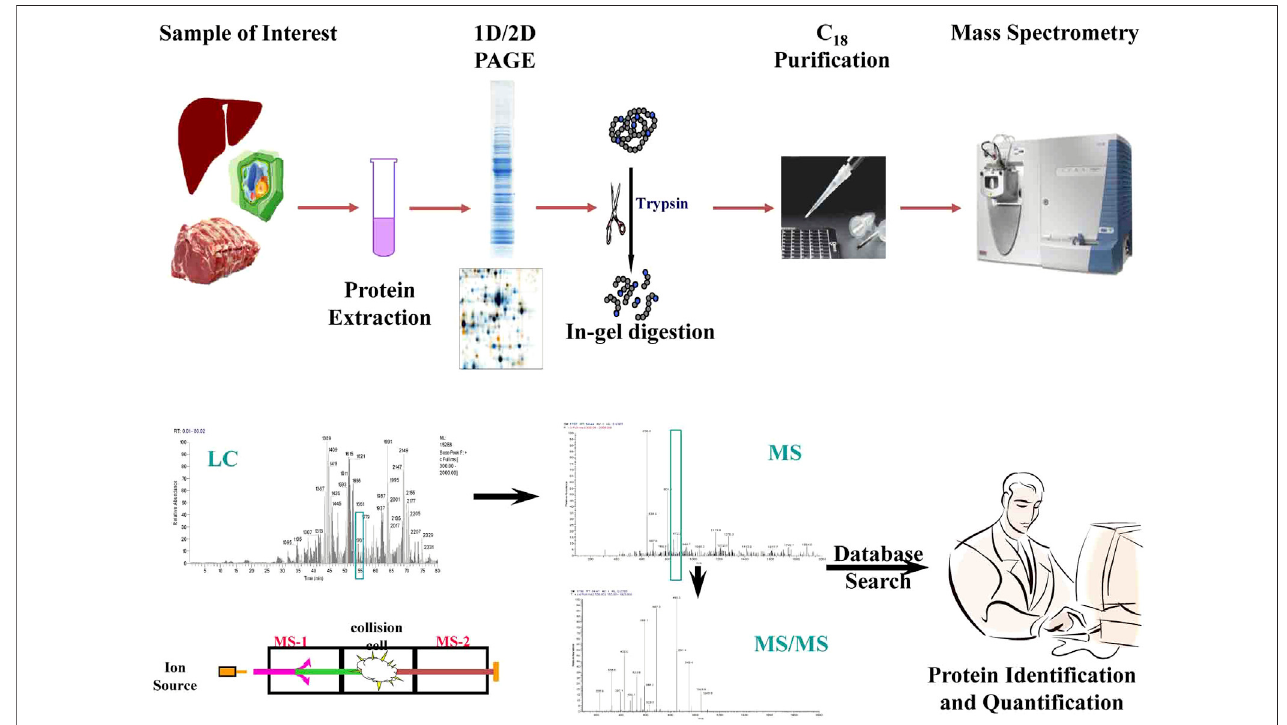
FIGURE 3 | Work fl ow of global proteome sequencing and quanti fi cation by mass spectrometry (MS/MS).